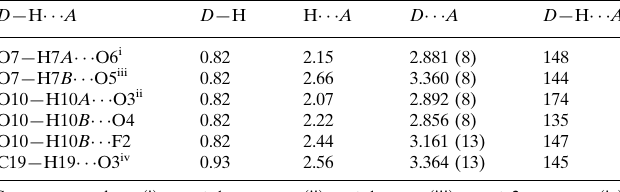
Hydrogen-bond geometry (A˚ , (cid:2)